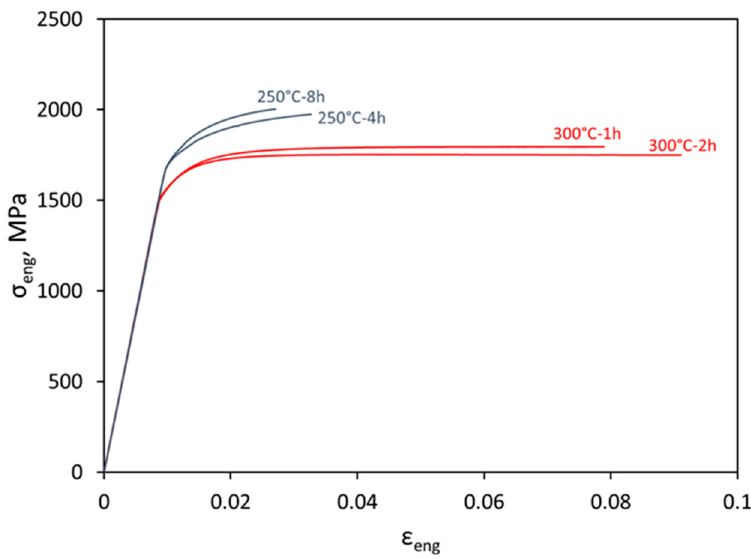
Figure 6. Representative engineering stress ( σ eng ) vs. strain ( ε eng ) curves.